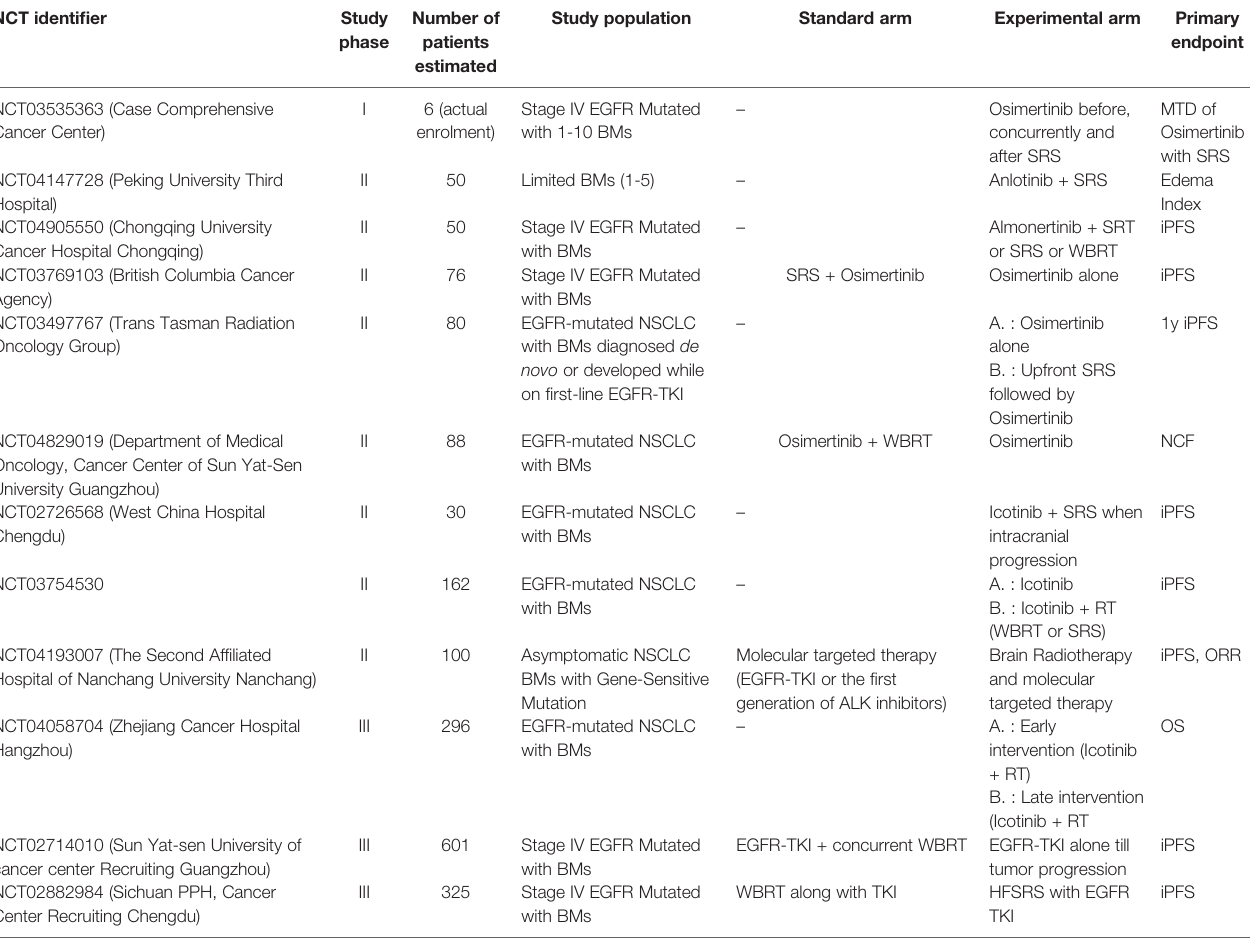
TABLE 4 | Selected ongoing clinical trials investigating the combination of target therapies and RT in NSCLC patients with